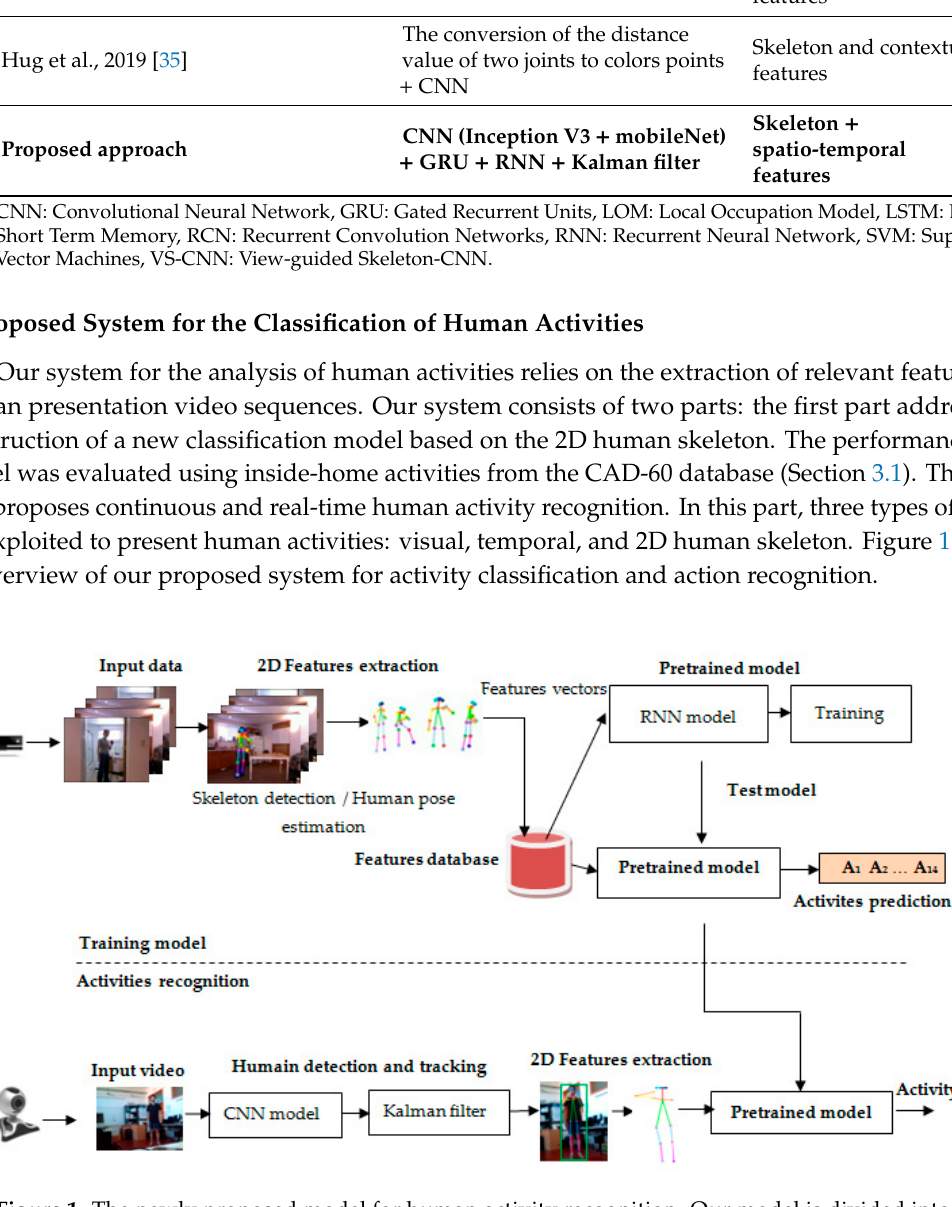
Figure 1. The newly proposed model for human activity recognition. Our model is divided into two parts: model training and activity recognition. This model is based on human pose estimation and human tracking.